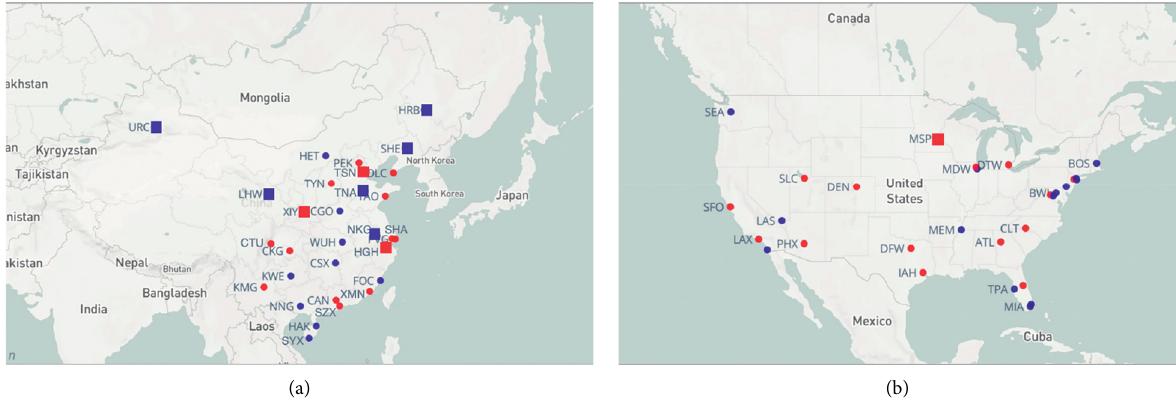
Figure 2: Geographic locations of the airports in China and USA. (a) Top 30 airports in China. (b) The FAA core 30 airports. Red markers are the airports in the rich clubs (i.e., the 15 airports in China and the 16 airports in USA), while squares are the airports that have been identified with higher betweenness centrality in the delay networks.